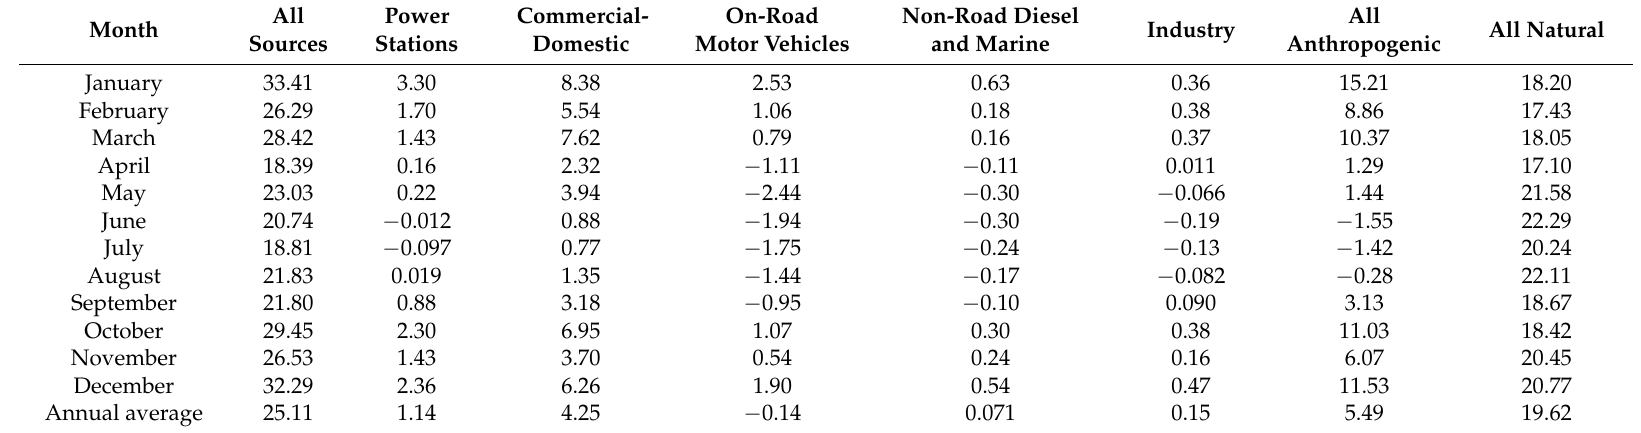
Table 3. Monthly average of daily maximum 1-h predicted ozone concentration (ppb) in the GMR for different months in 2008 under various emission scenarios.